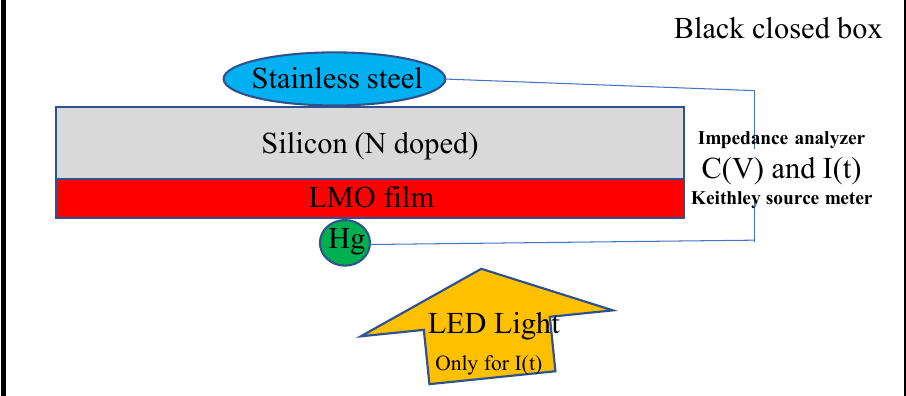
Figure 1. A schematic diagram of the experimental setup of the capacitance meter with a mercury probe.